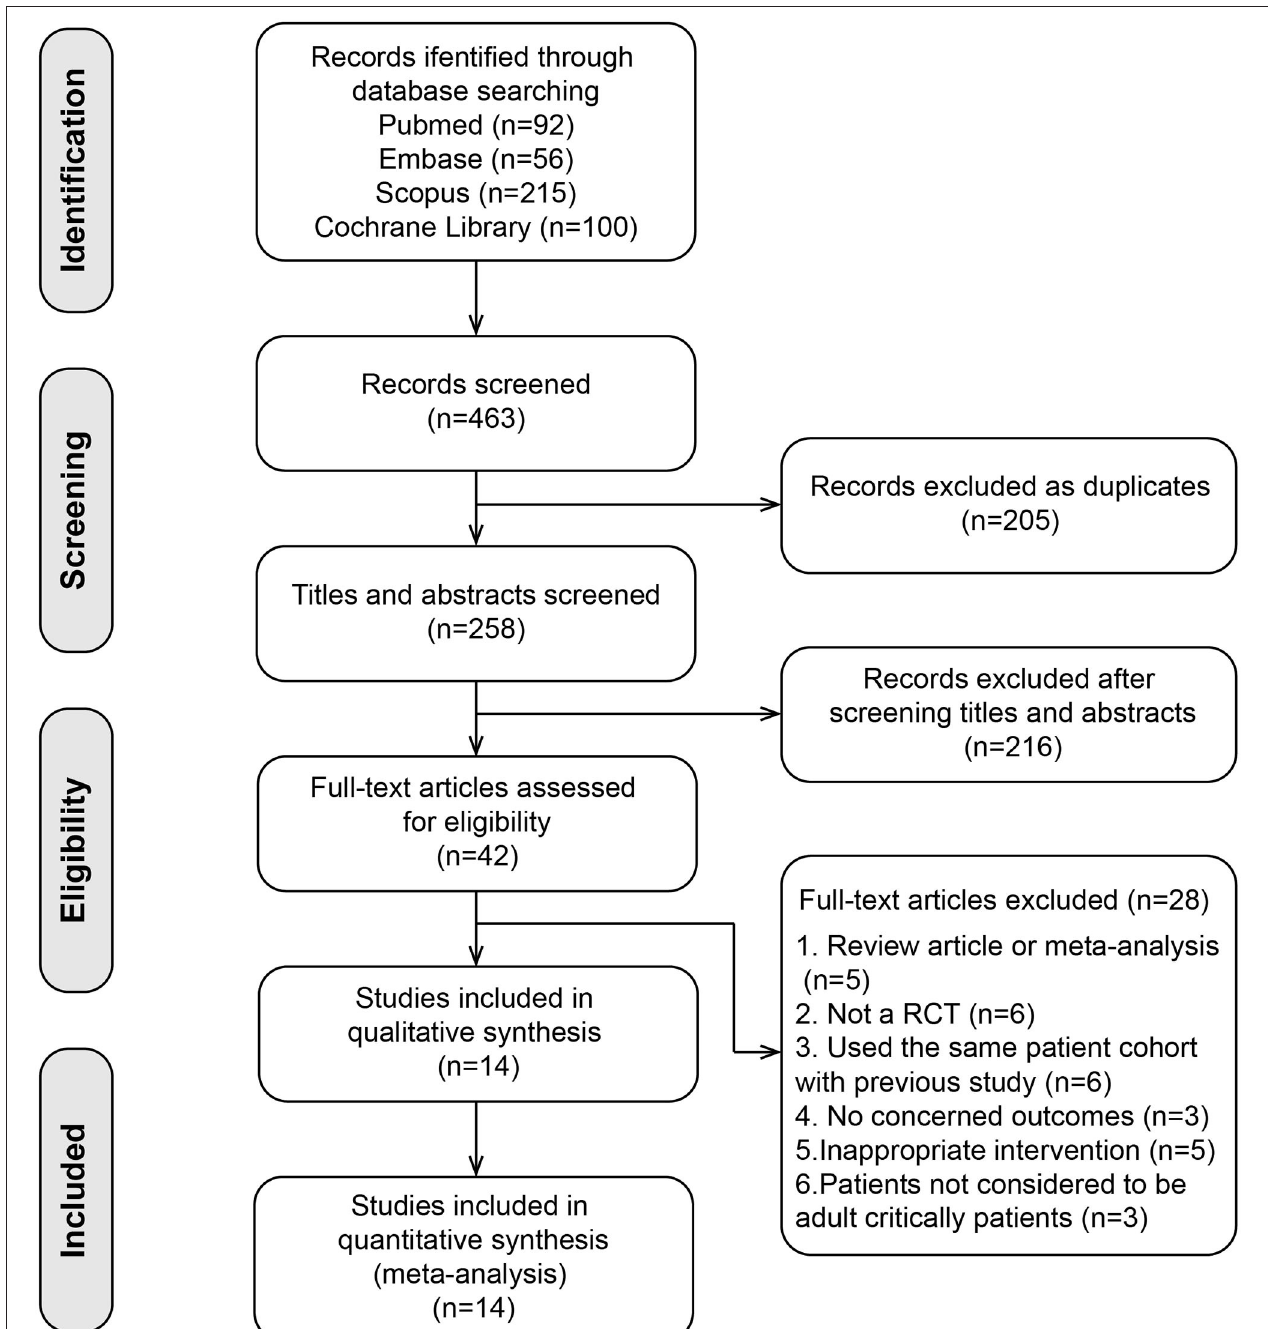
FIGURE 1 | Flow diagram for the selection of studies.